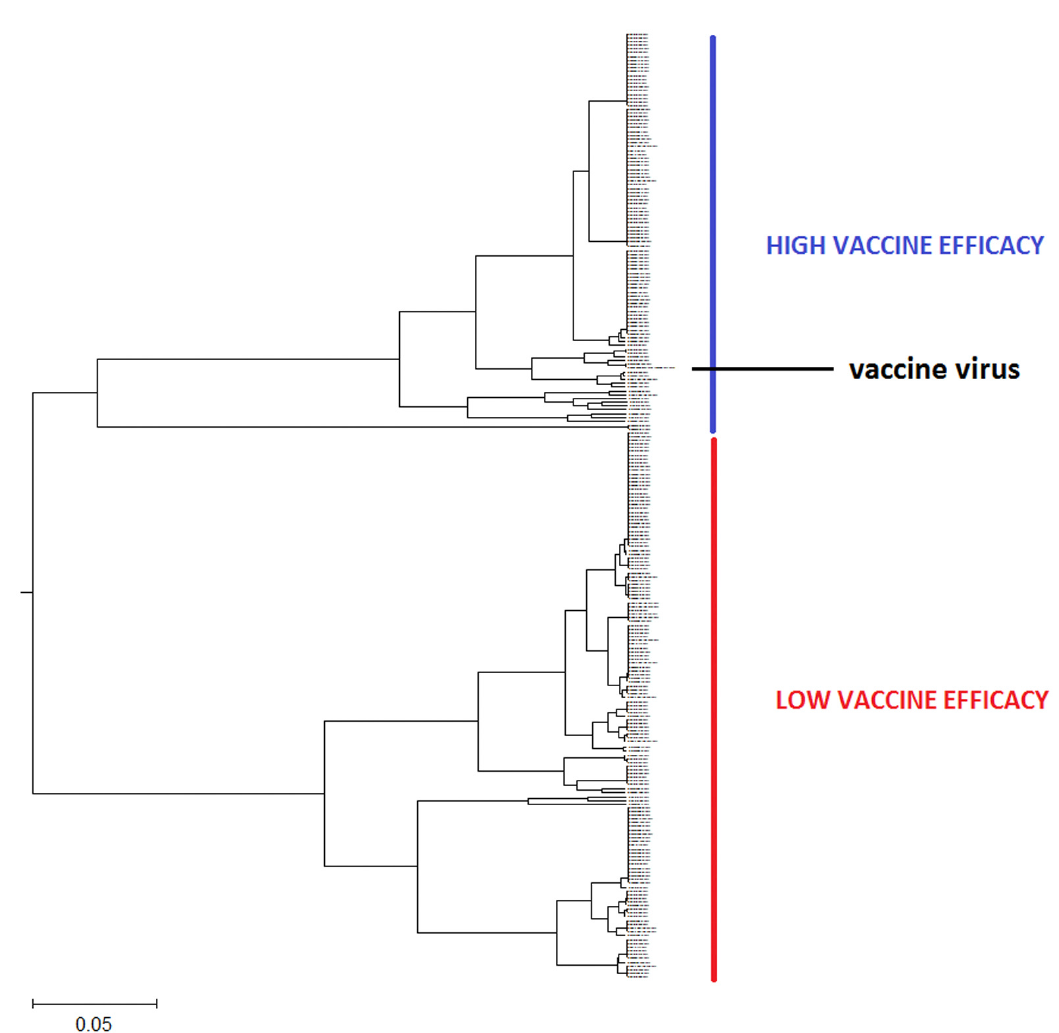
Figure 1. The schematic presentation of the ISM-based phylogenetic tree of HA1 from human H3N2 influenza viruses collected in Australia from July to September 2017. This tree in high resolution is given in Figure